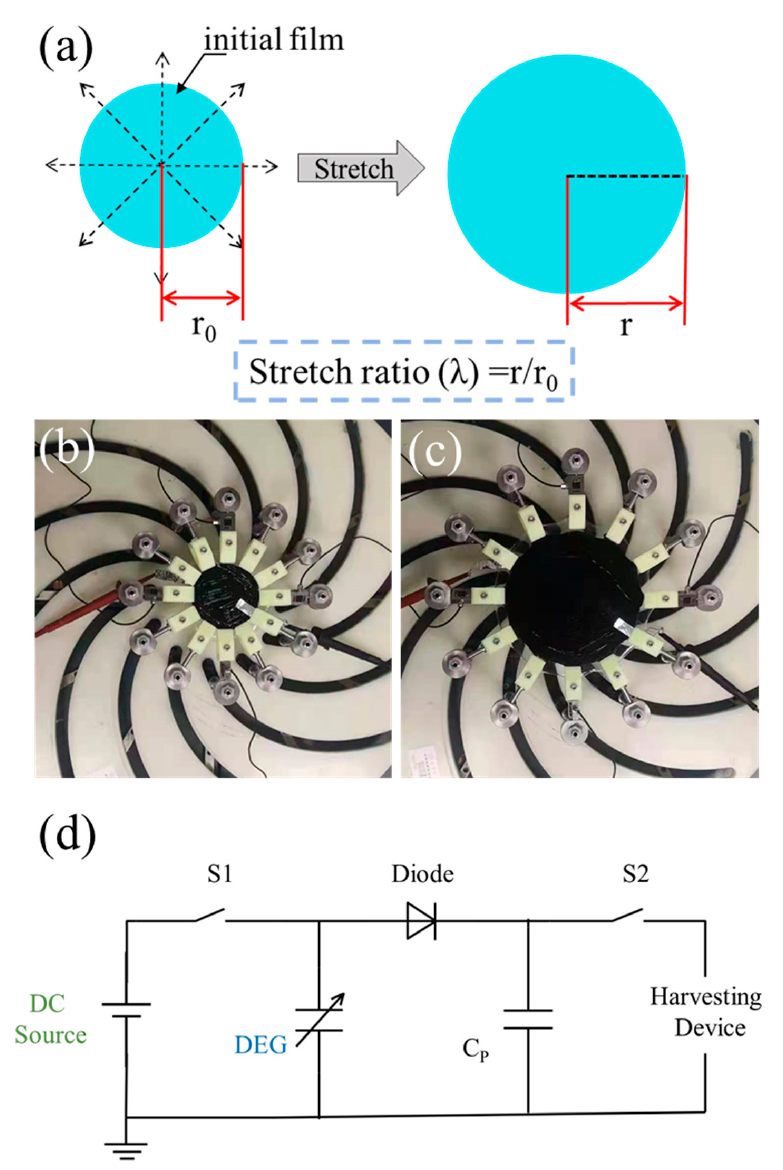
Figure 3. ( a ) Schematic diagram of equibiaxial stretch. ( b ) Released state and ( c ) stretched state of homemade equibiaxial stretch device. ( d ) Circuit principle adopted in this study.